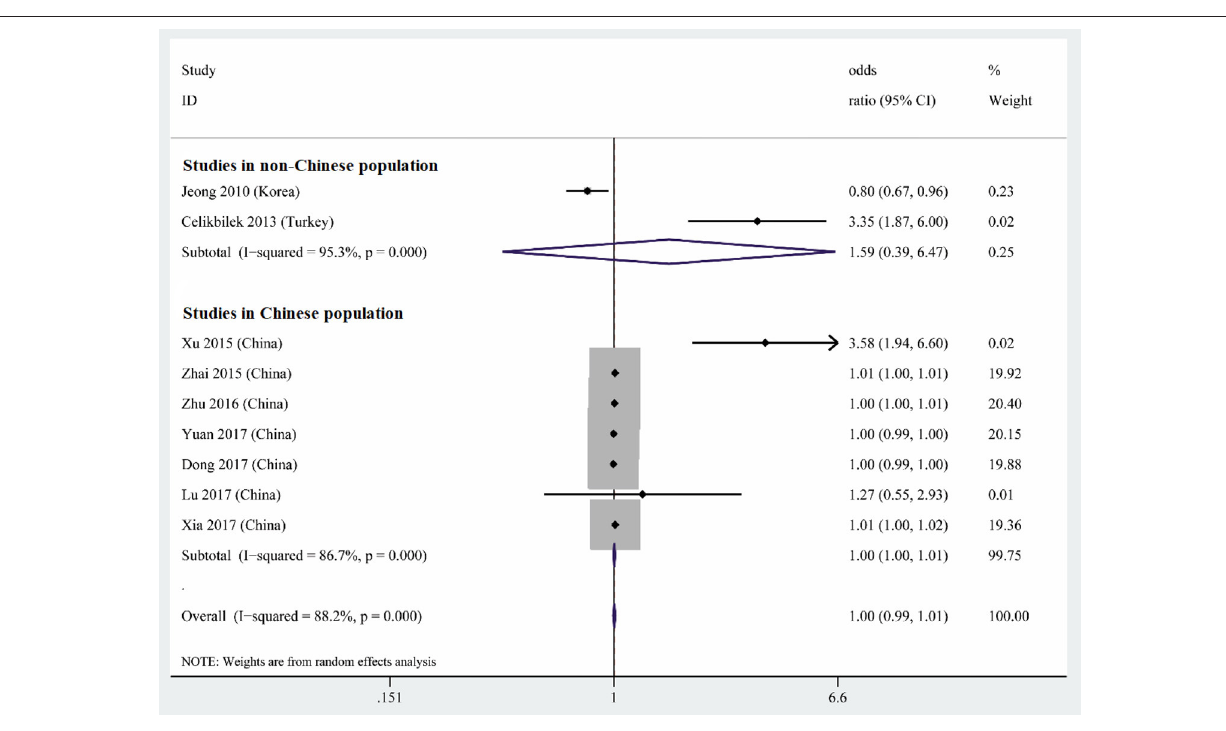
Frontiers in Neurology |